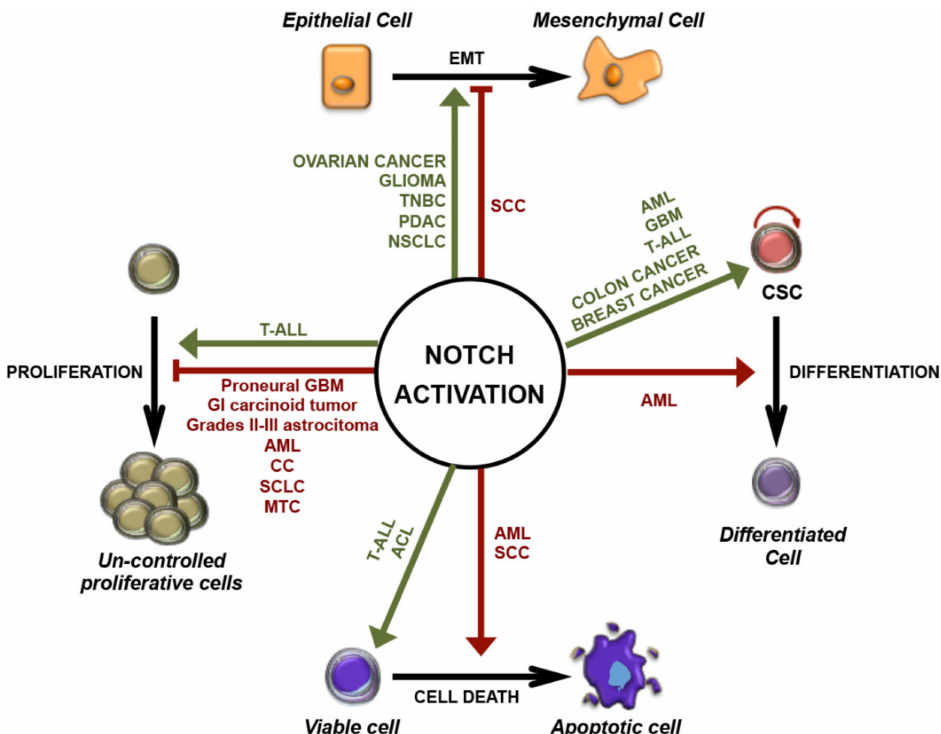
Figure 2. Pleiotropic functions of Notch activation in cancer. Schematic representation of oncogenic (green) and tumor- suppressive (red) roles of Notch signaling in different cancers: stimulation or inhibition of uncontrolled proliferation; regulation of epithelial-mesenchymal transition (EMT); induction of differentiation or maintenance of cancer stem cells (CSCs); promotion of cell survival or cell death. ACL: lung adenocarcinoma; AML: acute myeloid leukemia; CC: cervical cancer; GI: gastrointestinal; GBM: glioblastoma multiforme; MTC: medullary thyroid carcinoma; NSCLC: non-small-cell lung cancer; PDAC: pancreatic ductal adenocarcinoma; SCLC: small-cell lung cancer; SCC: squamous cell carcinoma; T-ALL: T-cell acute lymphoblastic leukemia; TNBC: triple-negative breast